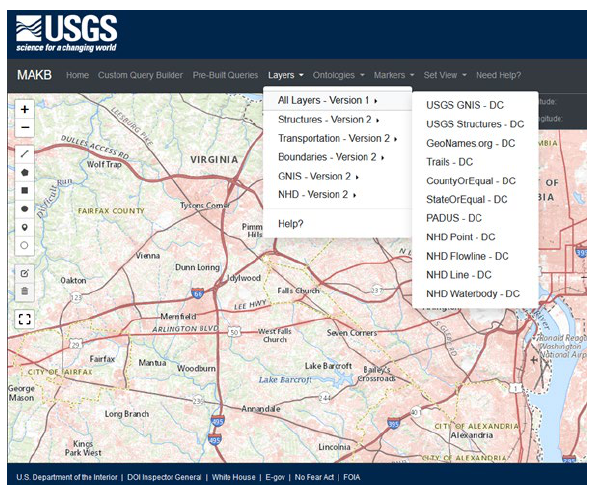
Figure 4 : The project UI showing how the metadata associated with an entity were displayed as RDF